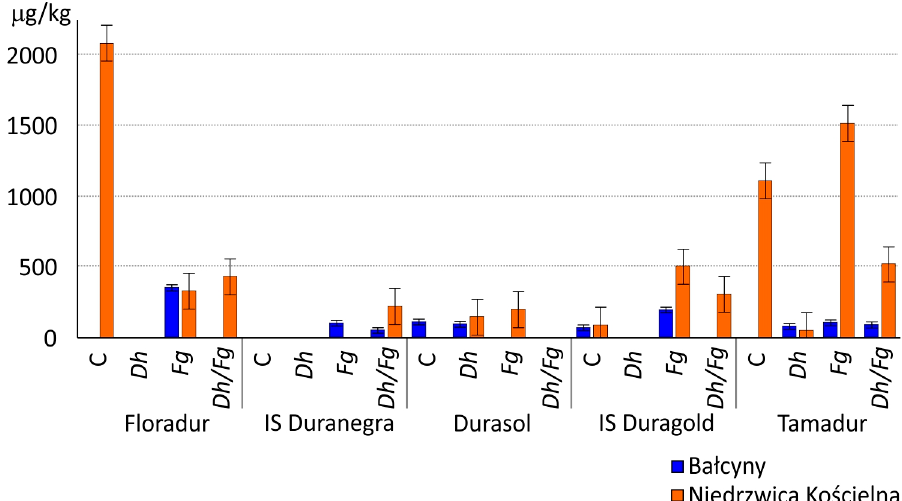
Figure 2. The levels of the DON (µg/kg) (including the error bars) in the grain of five T. durum cultivars. C— control- without biocontrol and pathogen, Dh —biocontrol with Debaryomyces hansenii , Fg— inoculation with Fusarium graminearum, Dh/Fg— biocontrol with D. hansenii + inoculation with F. graminearum.